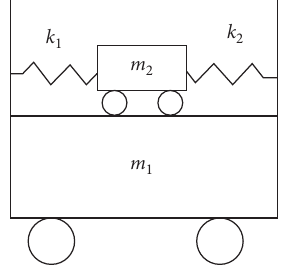
Figure 3: Model of the vehicle and cargo that is assumed in standby status.